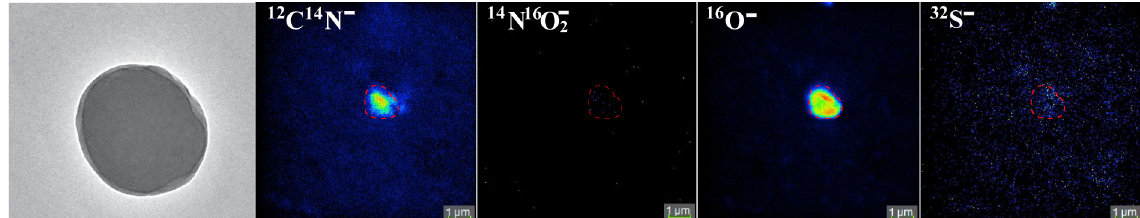
, 16 O − , and 32 S − from a near-spherical OM 2